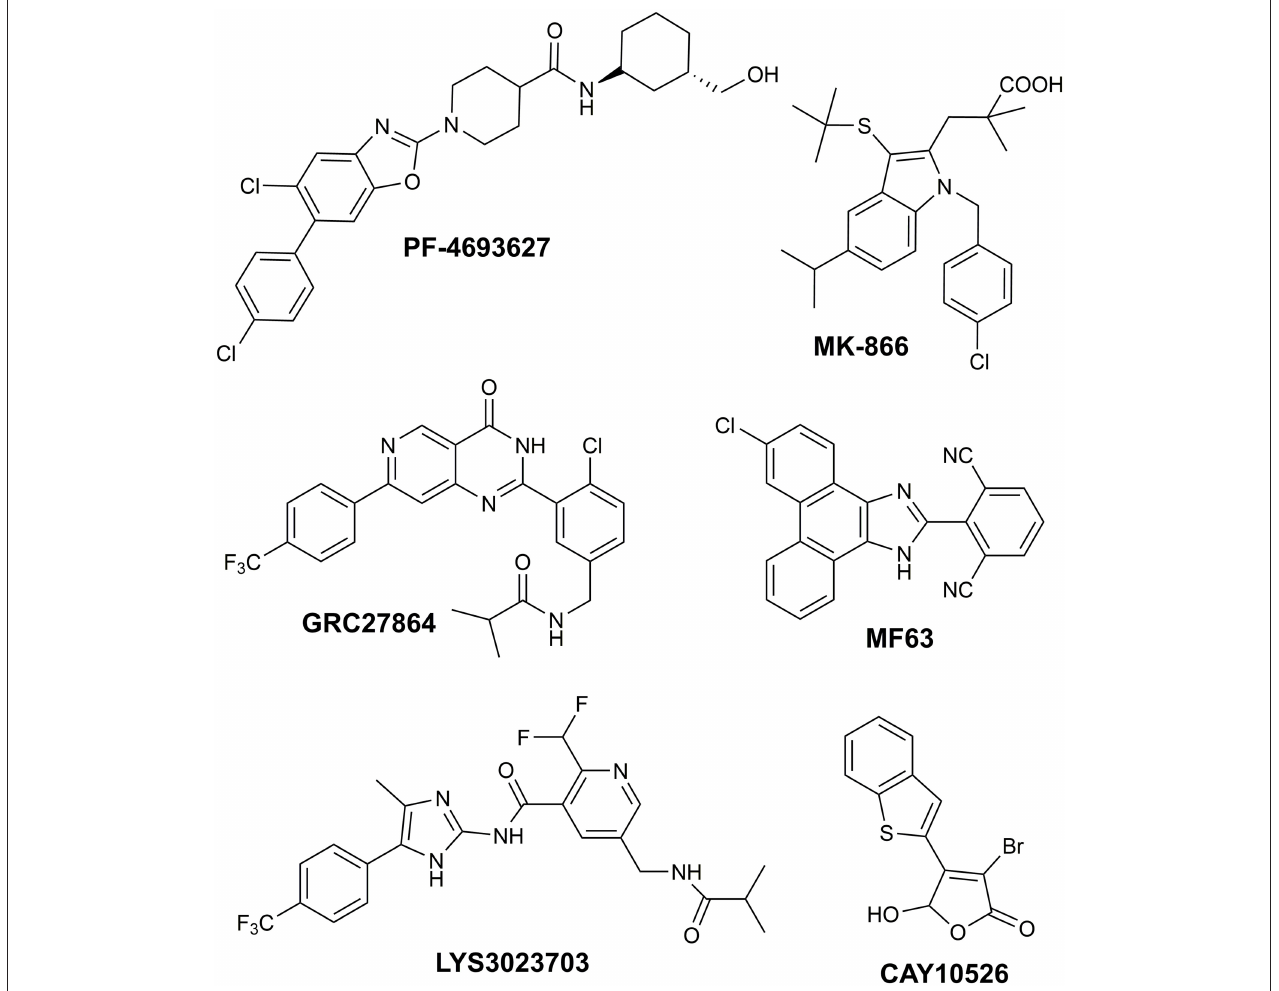
FIGURE 1 | Molecular structure of known mPGES-1